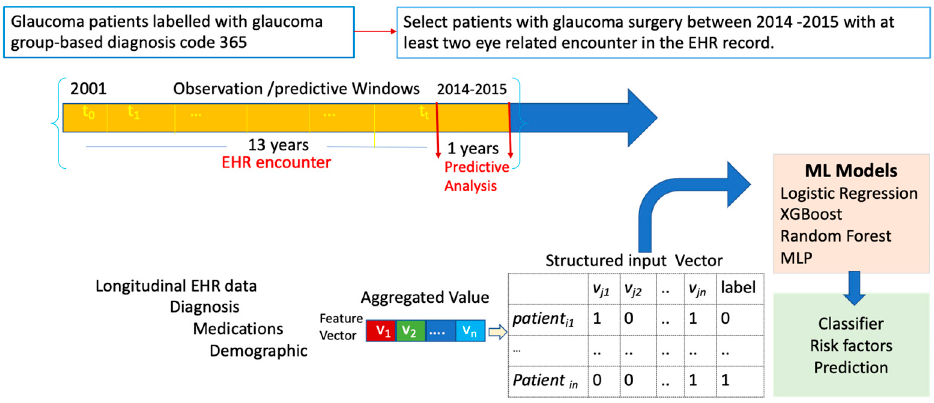
Figure 1. Overview of data pre-processing and the input data vector for predictive machine learning analysis.